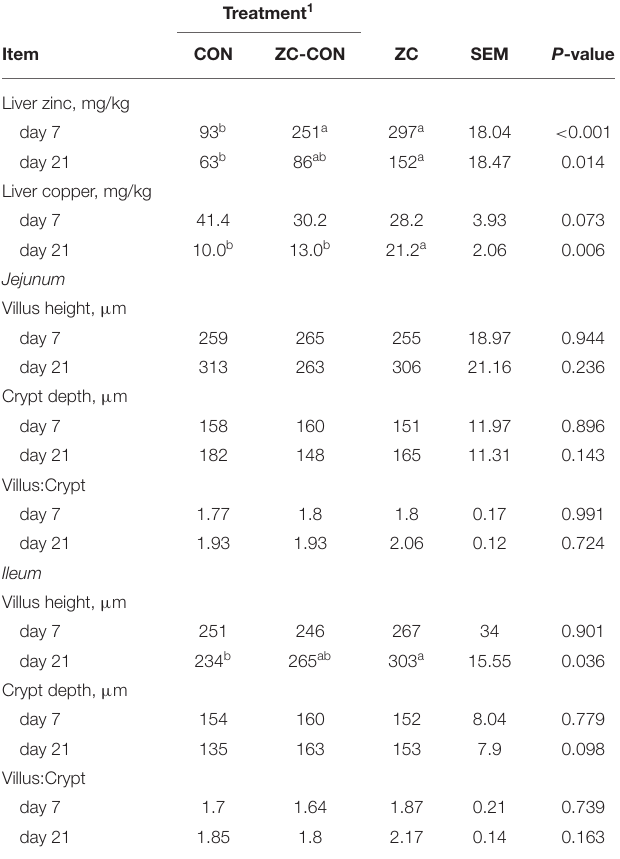
TABLE 4 | Liver zinc concentrations, jejunum and ileum morphology and ghrelin positive fundic cells at d 7 and d 21 in pigs fed a control (CON) diet for 21 d, a diet containing pharmacological zinc and copper for 7 d followed by a control diet for 14 d (ZC-CON), or a diet containing pharmacological zinc and copper for 21 d (ZC) (Expt. 1).